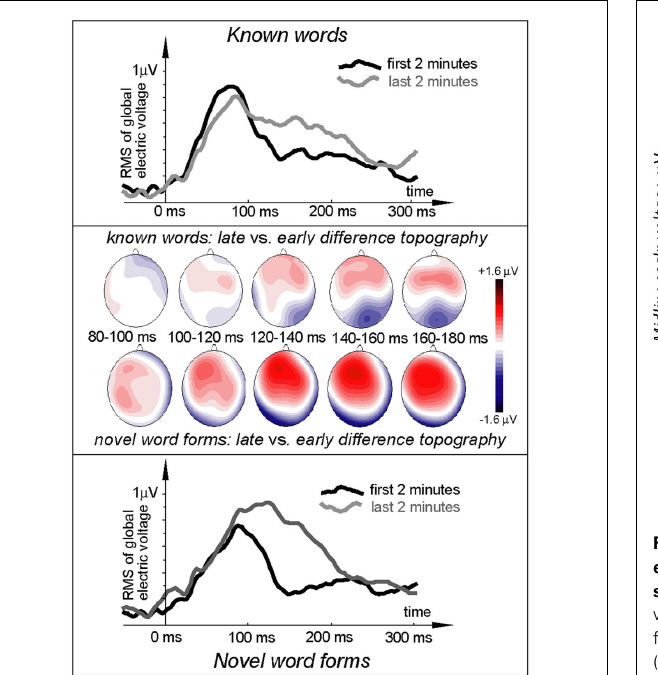
FIGURE 3 | Electric brain response (global activation computed as RMS across all EEG electrodes; grand-average data) for word and pseudo-word stimuli early and late in the learning session and voltage topography maps for comparison between the early and late response (based on “late” minus “early” subtraction). Note the larger change in the pseudo-word response by the end of the exposure, topographically visible as an increased left-frontal positivity in the voltage maps.